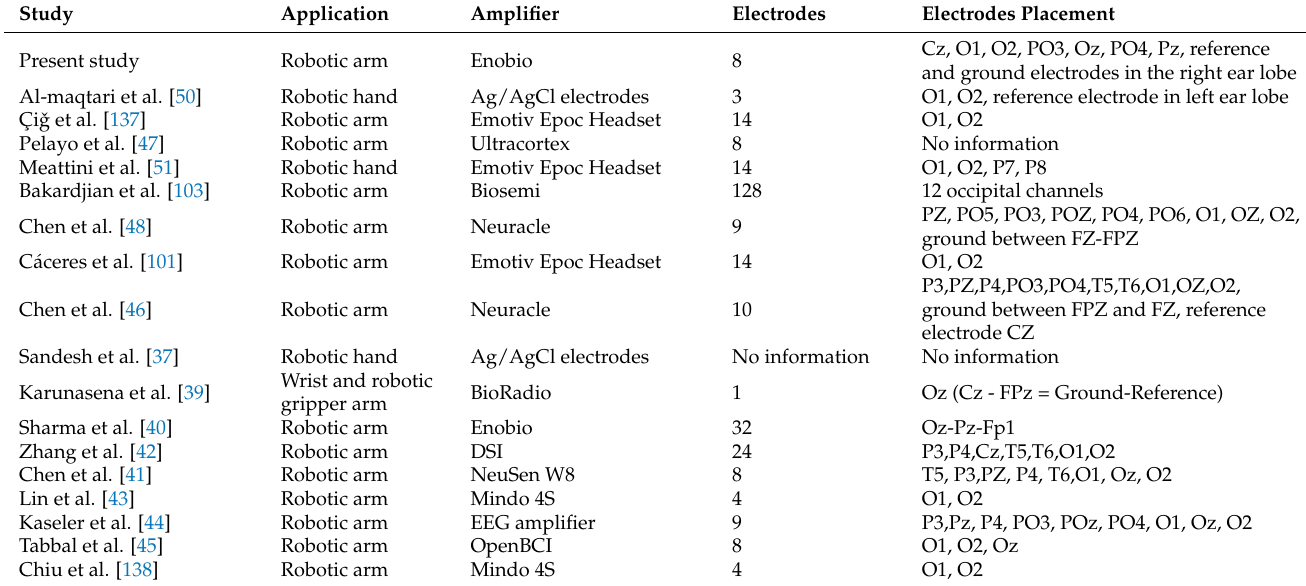
Table 8. Robotic application, acquisition device and electrode characteristics.